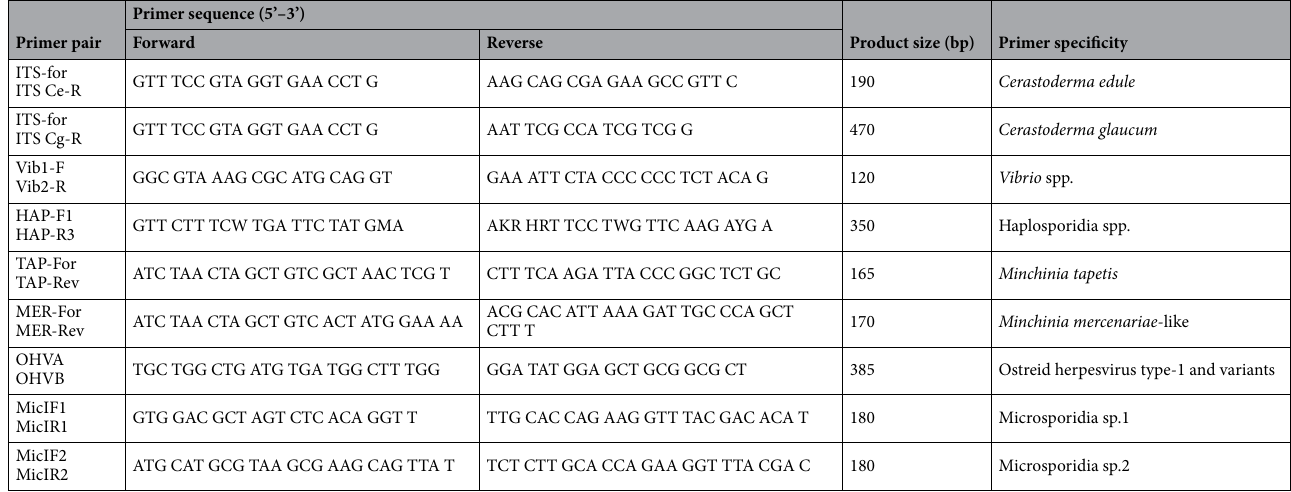
Table 5. Description of PCR primer pairs showing sequences for each forward and reverse primer and expected product